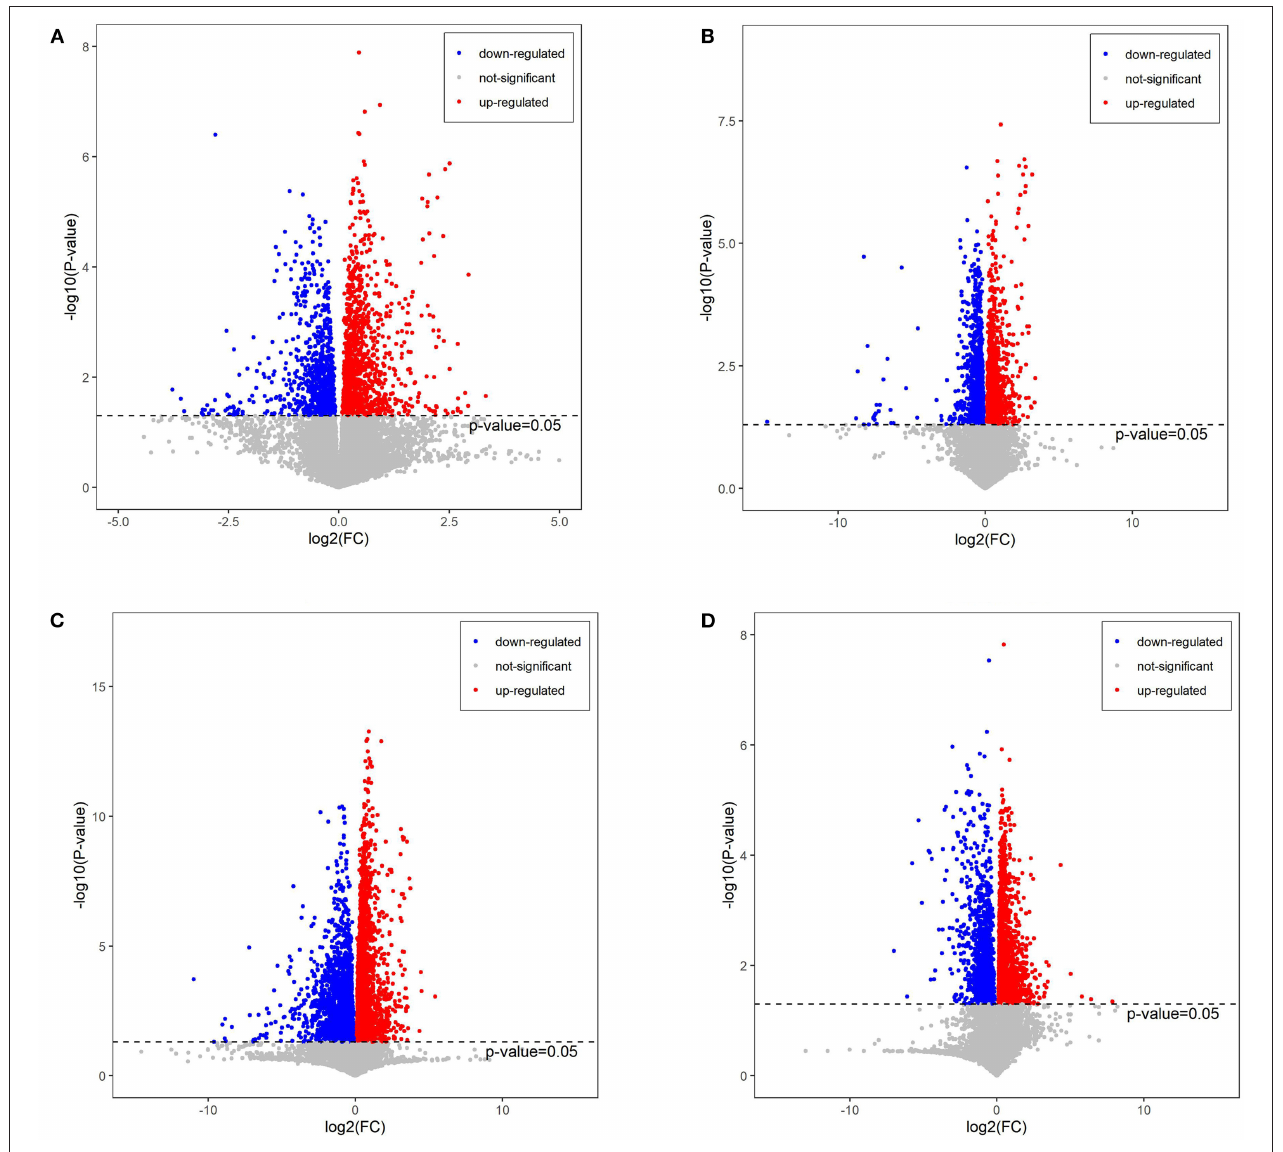
FIGURE 6 | Volcano plot of metabolites in different combinations. (A) PBA0 vs. control. (B) PBA.1 vs. control. (C) PBA1 vs. control. (D) PBA5 vs.